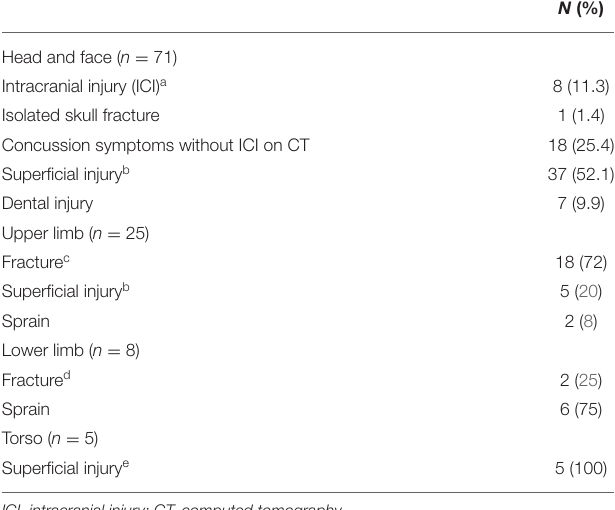
TABLE 1 | Characteristics of unpowered scooter-related injuries. Characteristics